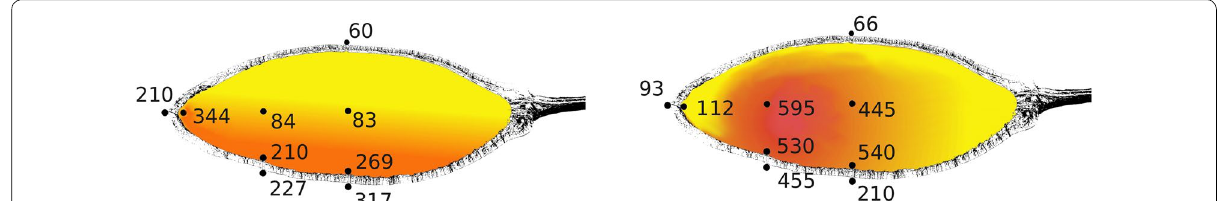
Fig. 6 Possible temperature distributions in A. digitata approximated from maximum temperatures (°C) at the end of heat exposure. See also charred region in fruit in Fig. 2d. Left: continual gradient. Right: smouldering seat. Yellow: low temperature; red: high